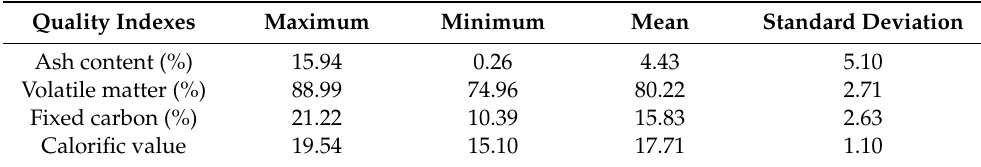
Table 1. Statistical description of four quality indexes for all